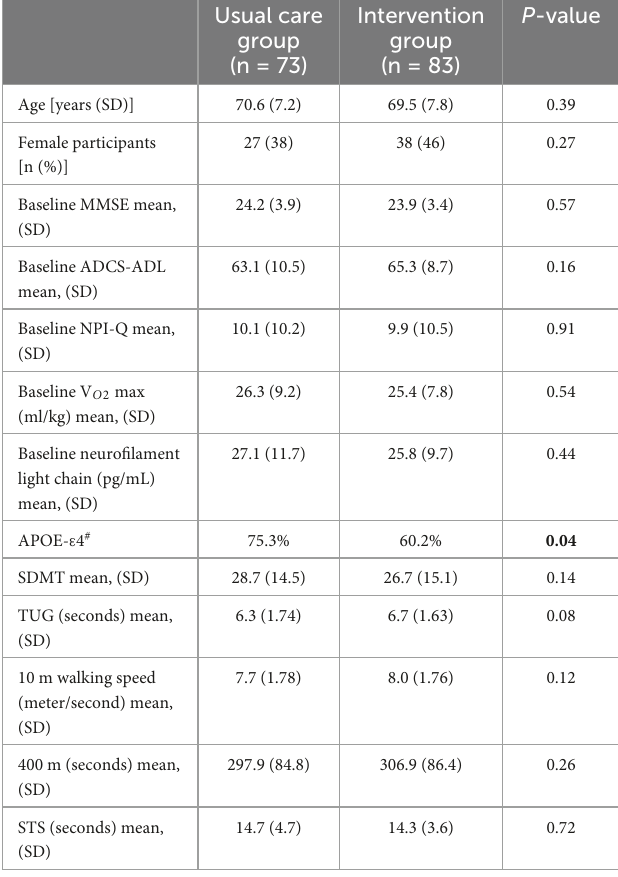
TABLE 1 Baseline demographics and clinical